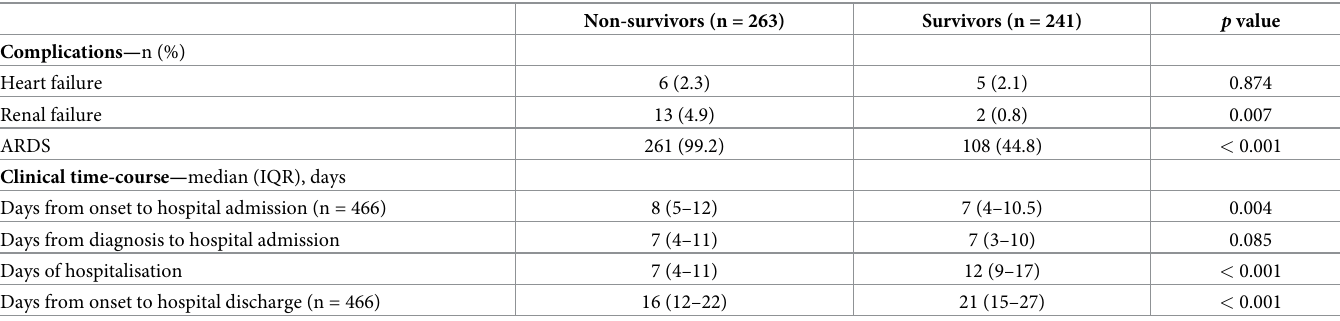
Table 3. Comparison of complications, clinical time course, and outcomes among survivors and non-survivors of COVID-19 infection. Non-survivors (n =